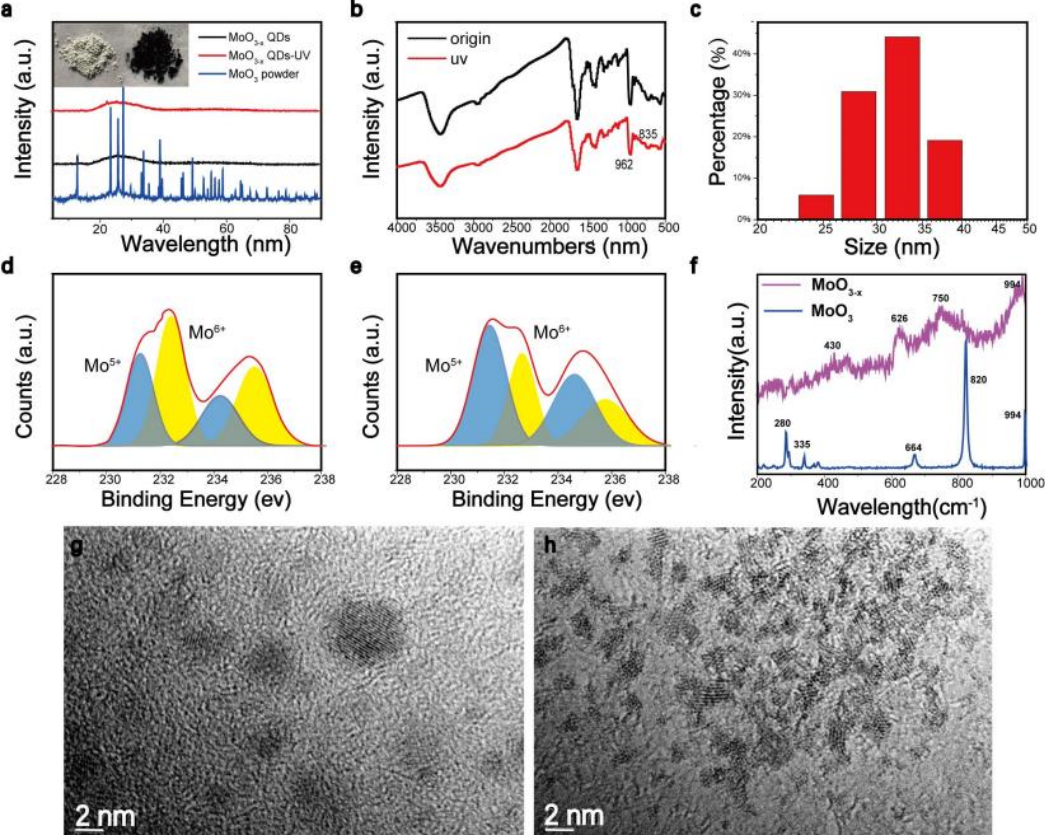
Figure 2. ( a ) XRD pattern of MoO 3-x nanostructures and photographs of α -MoO 3 powder and MoO 3-x nanostructures powder (inset image). ( b ) FTIR spectra of MoO 3-x nanostructures with and without UV. ( c ) DLS spectrum of MoO 3-x nanostructures. ( d ) Mo 3d core level spectra of MoO 3-x nanostructures without UV excitation and ( e ) Mo 3d core level spectra of MoO 3-x nanostructures without UV excitation. ( f ) Raman spectra of MoO 3 and MoO 3-x nanostructure. ( g ) TEM images of MoO 3-x nanostructures without ultraviolet light irradiation and ( h ) irradiated by ultraviolet light.